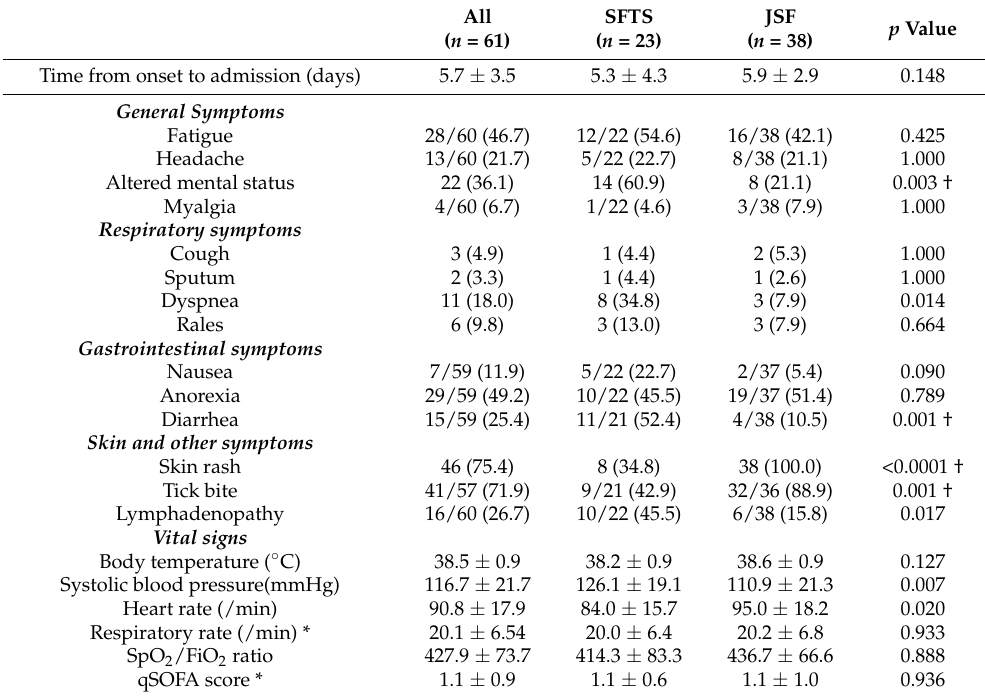
Table 2. Symptoms and physical findings at admission in patients with SFTS or